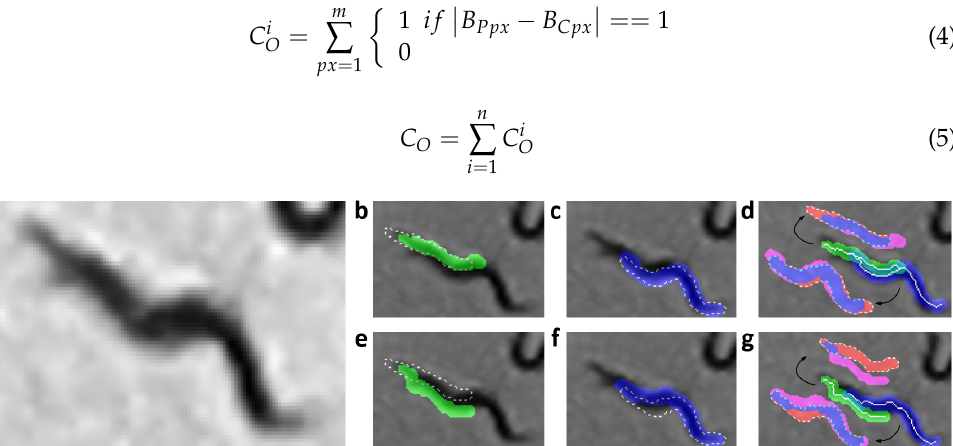
Figure 5. Overlap criterion evaluation. The pixels in red and magenta are the error of overlap with the previous state. The white pixels are the pixels of the skeleton prediction, which are used to reconstruct the body of each worm (segmentation in blue and green). The dashed line segmentation is the previous state segmentation. ( a ) Grayscale image. ( b , e ) Previous state ( Bps px ) in white dashed line and current state ( Bcs px ) in green. ( c , f ) Previous state ( Bps px in white dashed line and current state ( Bcs px ) in blue. ( d ) Evaluation with low overlap criterion. ( g ) Evaluation with high overlap